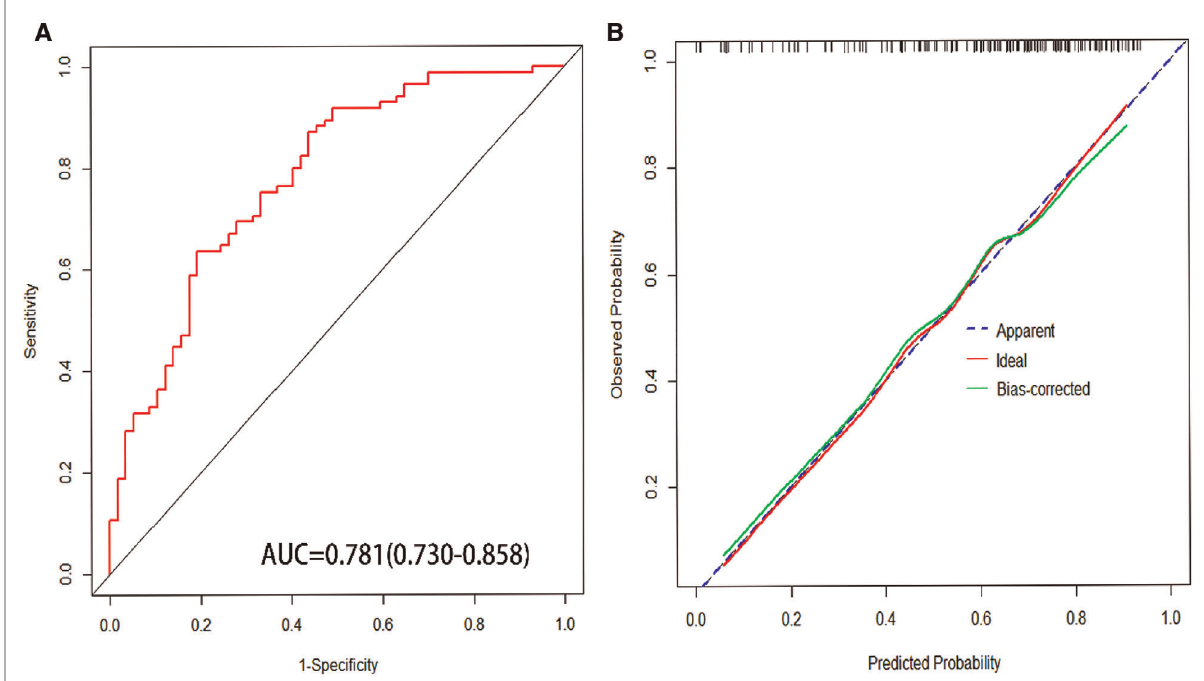
FIGURE 3 ( A ) Area under receiver operating characteristic (AUROC) of nomogram for predicting esophagogastric variceal bleeding with hepatitis B cirrhosis. ( B ) The calibration curves for predicting esophagogastric variceal bleeding with hepatitis B